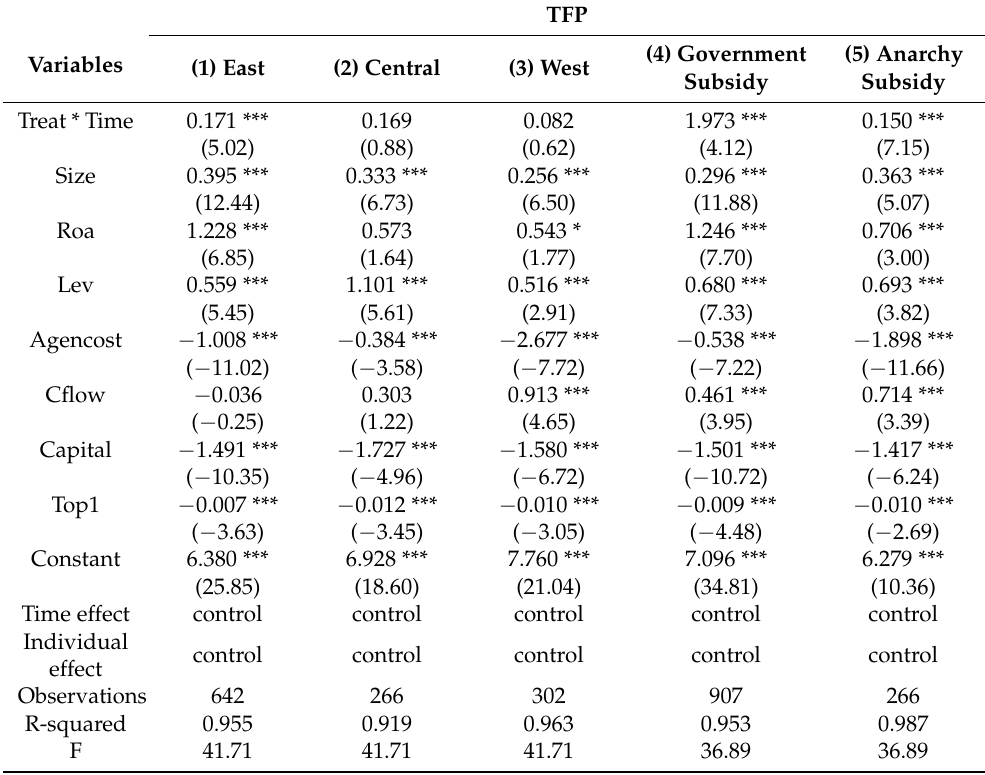
Table 8. The first set of tests for